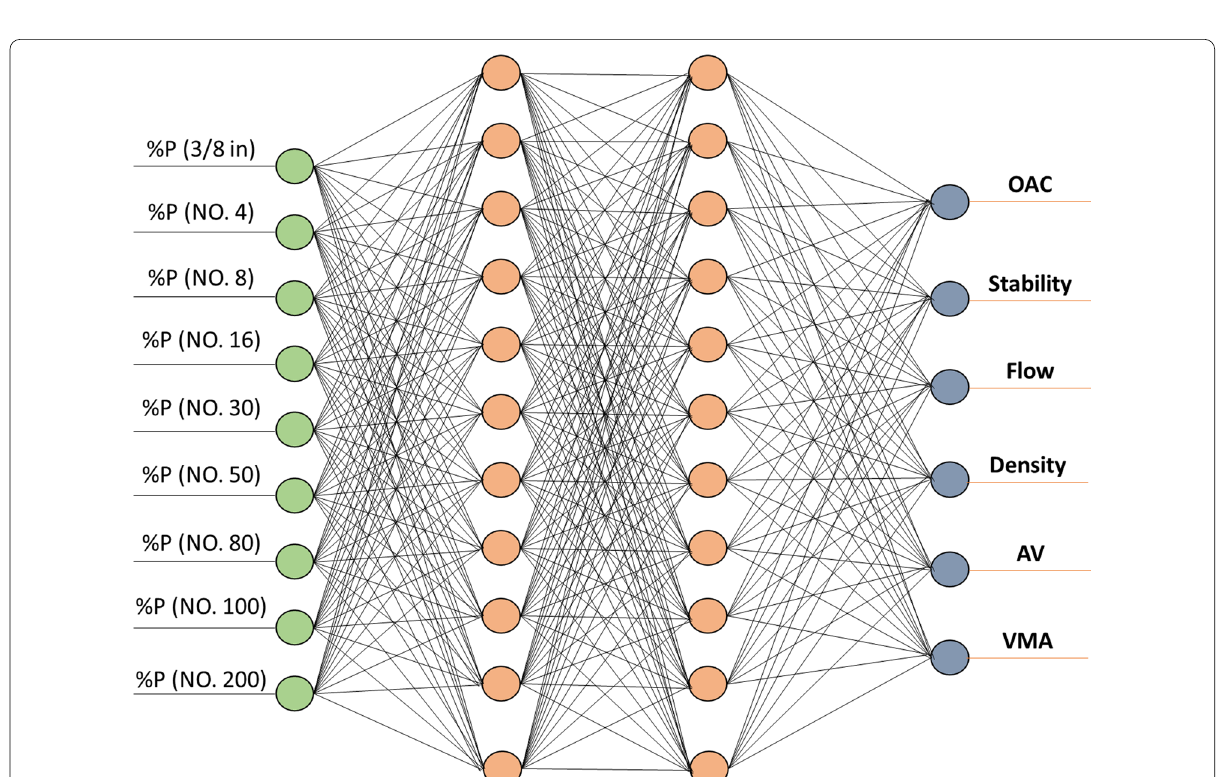
Fig. 5 The optimum ANN that provide the best predictions for all the six